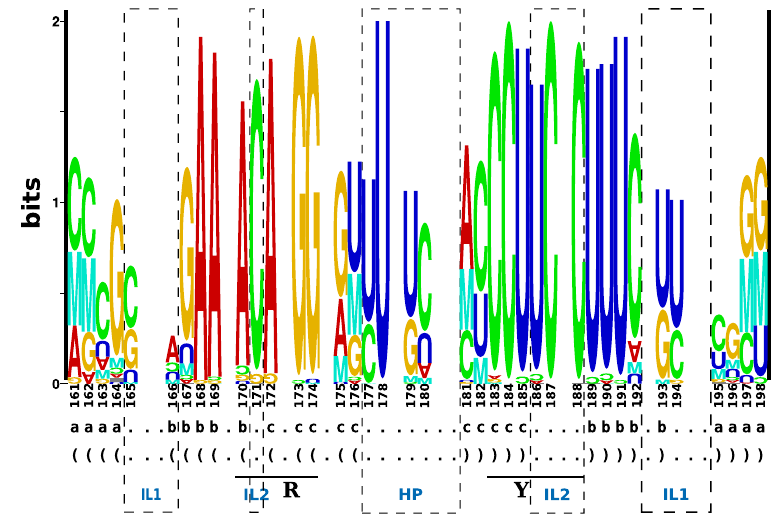
Figure 2. Structure logo of terminal right stem-loop. This logo 46 is based on the same alignment (see Supplementary Fig. S2) of 95 pospiviroids as used for Fig. 1c. The height of nucleotide characters is proportional to the observed frequency of nucleotides in the alignment and the expected (a priori) frequency p = 0.25; nucleotide characters that appear less than expected are displayed up-side-down. The mutual information (marked by ‘M’) between base-paired positions, as indicated in the two bottom lines, is calculated as the relative entropy between the fractions of complementary bases and the number of basepairs one would expect by chance from the distribution of nucleotides at the involved positions. The nucleotide numbering is as in Fig. 1c; missing numbers denote that the respective column of the alignment contains mostly gaps. The RY motif critical for binding of Virp1 is outlined and marked by R and Y. The sequences of internal loops are marked by IL1 and IL2, respectively, and the hairpin loop sequence by